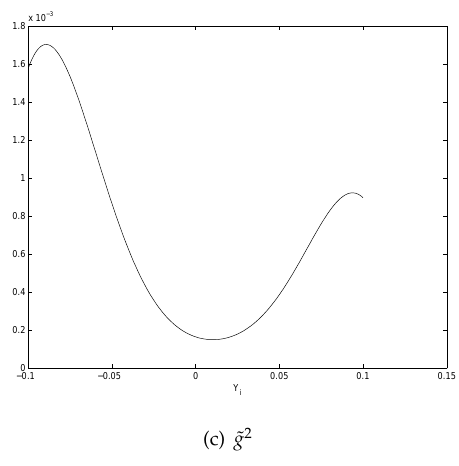
Figure 13. Polynomial Approximations of f , g , g 2 .